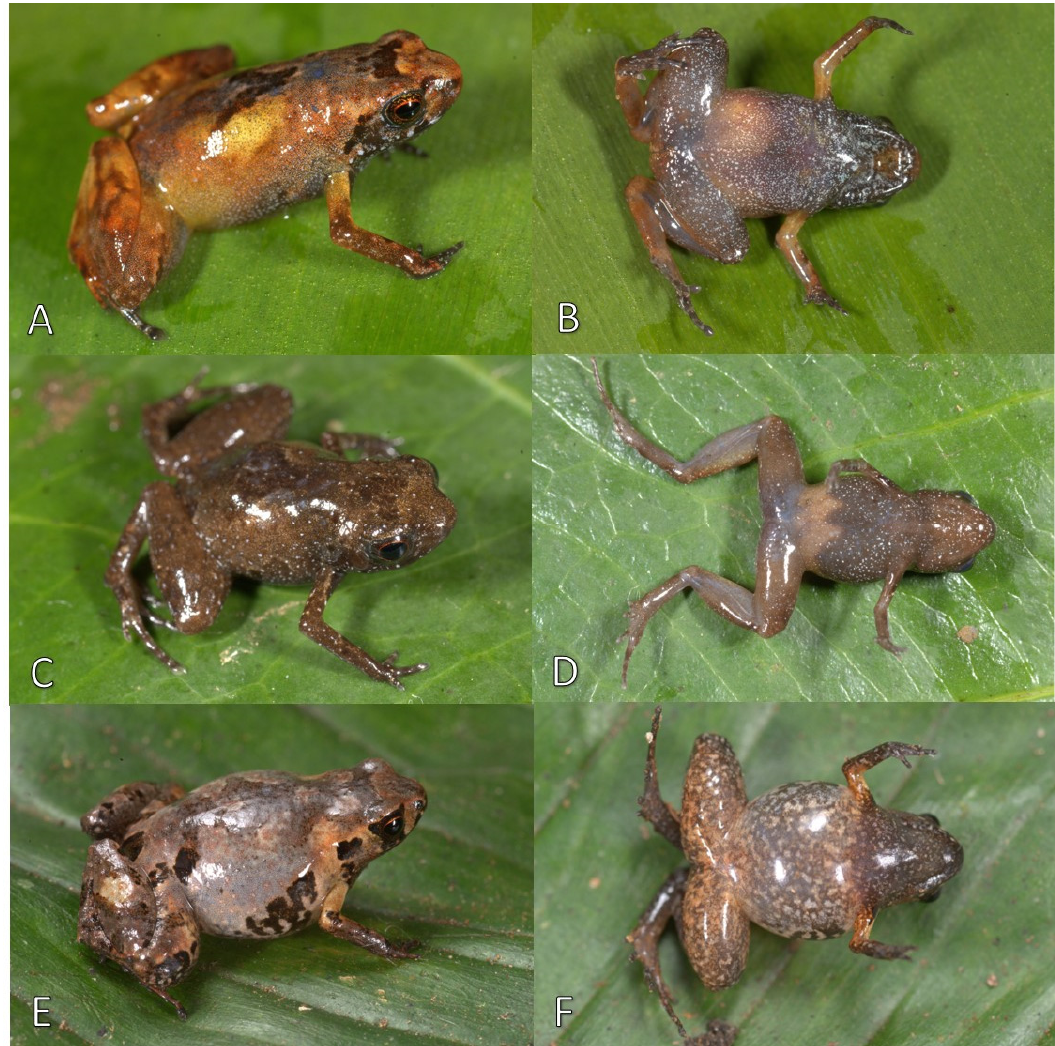
Figure 9. Photographs of live specimens of Noblella losamigos sp. n. ( A ) Dorsal view and ( B ) ventral view of MUSM 30427, adult female paratype (SVL 11.6 mm); ( C ) dorsal view and ( D ) ventral view of MVZ:Herp:292684, adult female paratype (SVL 13.2 mm); ( E ) dorsal view and ( F ) ventral view of CORBIDI 17522, adult female paratype (SVL 13.6 mm). Photographs by A. Catenazzi.